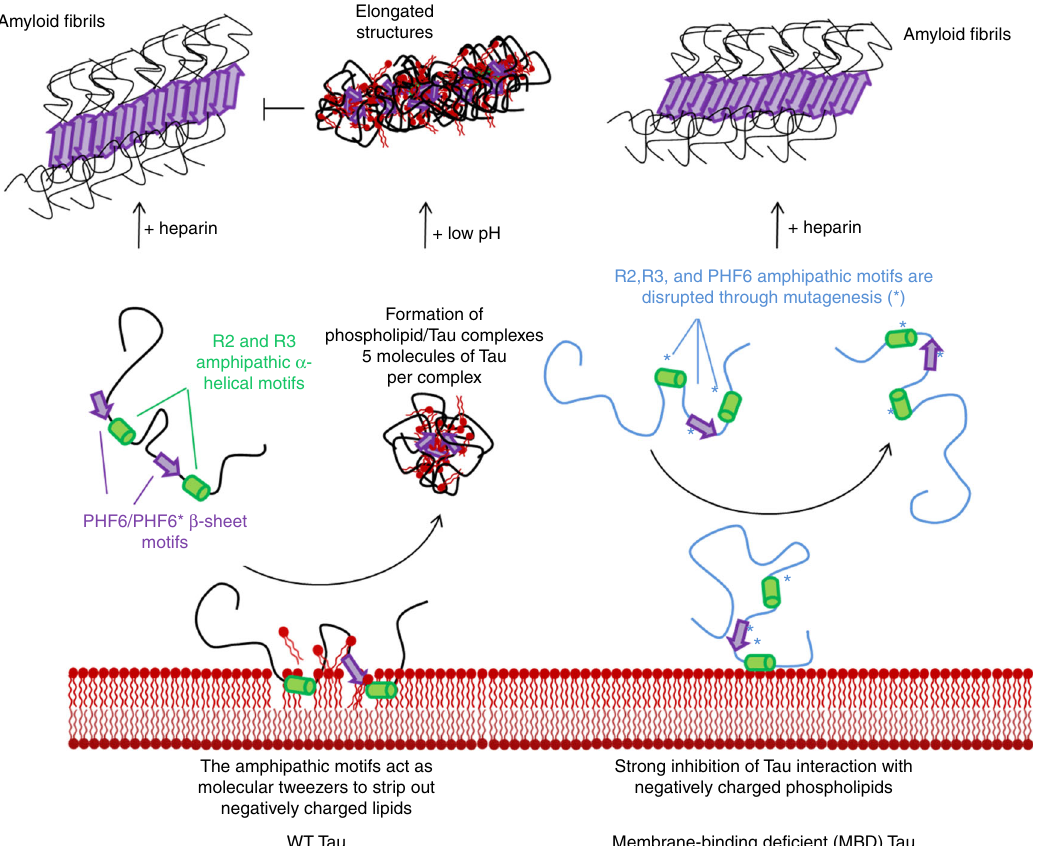
Fig. 9 Schematic depiction of our working model that summarizes our fi ndings for the interaction of Tau with negatively charged phospholipids. Tau forms fi brils readily in the presence of heparin, and Tau monomers interact with vesicles containing negatively charged phospholipids, potentially though the formation of short amphipathic α -helical (green) and β -sheet (purple) motifs 16,17,20 . Subsequently, phospholipid molecules are segregated into highly stable protein/phospholipid complexes, possibly through a tweezers mechanism (left). The core of these protein/phospholipid complexes consists of PHF6 and PHF6*, and regions C-terminal to these two motifs, whereby only the PHF6 is folded into a β -sheet, while the rest of the core remains unfolded. Based on these fi ndings, mutants were designed that retain the ability to from fi brils in the presence of heparin, but no longer interact with phospholipids (right) to form protein/phospholipid complexes, thus providing powerful tools to investigate how membrane binding affects the normal and pathological functions of